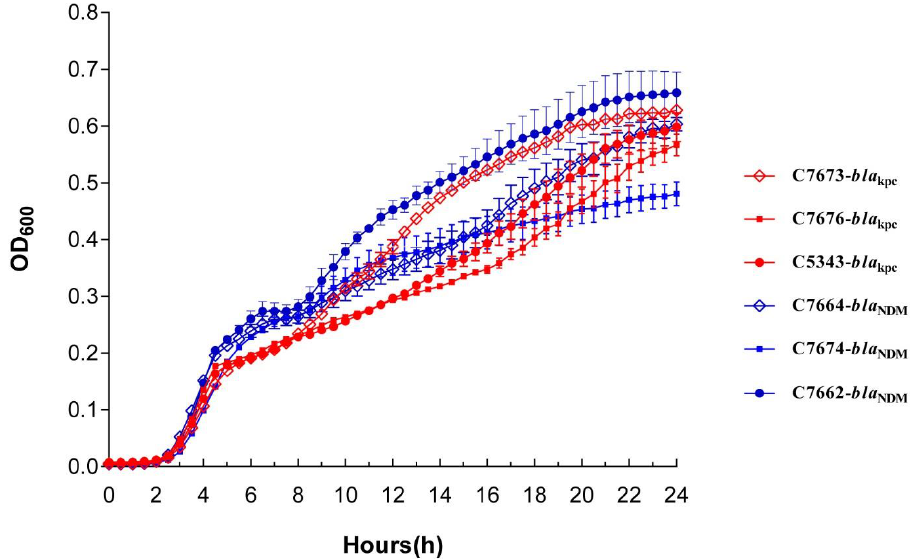
Figure 4. Growth curve for six strains of Klebsiella pneumoniae (C7676- bla KPC , C5343- bla KPC , C7673- bla KPC , C7674- bla NDM , C7662- bla NDM , and C7664- bla NDM ). Error bars represent standard deviation.